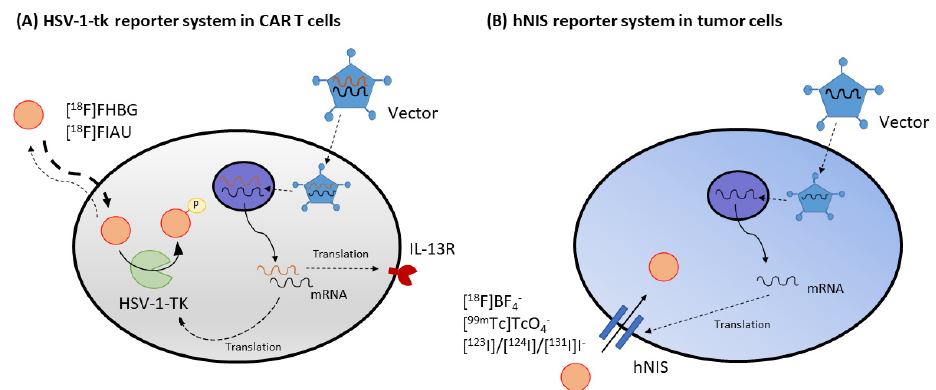
Figure 2. Successful reporter systems combined with molecular imaging are applied in clinical trials. ( A ) Keu et al. (2017) reported tumor-associated CD8 + engineered T lymphocytes expressing both HSV1-tk and interleukin-13 (IL-13) zetakine domain, a chimeric antigen receptor, could be tracked longitudinally by [ 18 F]FHBG imaging in patients with high-grade glioma [96]. ( B ) Measles virus and vesicular stomatitis virus expressing hNIS were tested in cancer patients. Assessment of clinical outcomes included [ 18 F]BF 4 − PET or [ 99m Tc]TcO 4 − SPECT imaging.